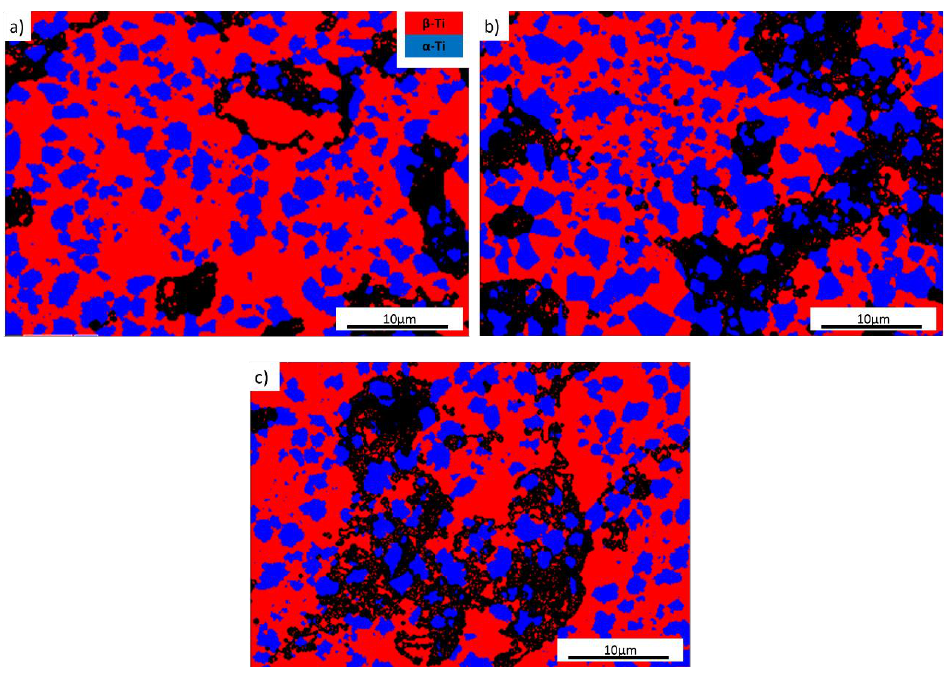
Figure 10. The EBSD contrast phase micrographs of ( a ) Ti-35Nb-6Mo milled at 40 h, ( b ) Ti-35Nb-6Mo milled at 60 h and ( c ) Ti-35Nb-6Mo milled at 40 h in the continuous mode.